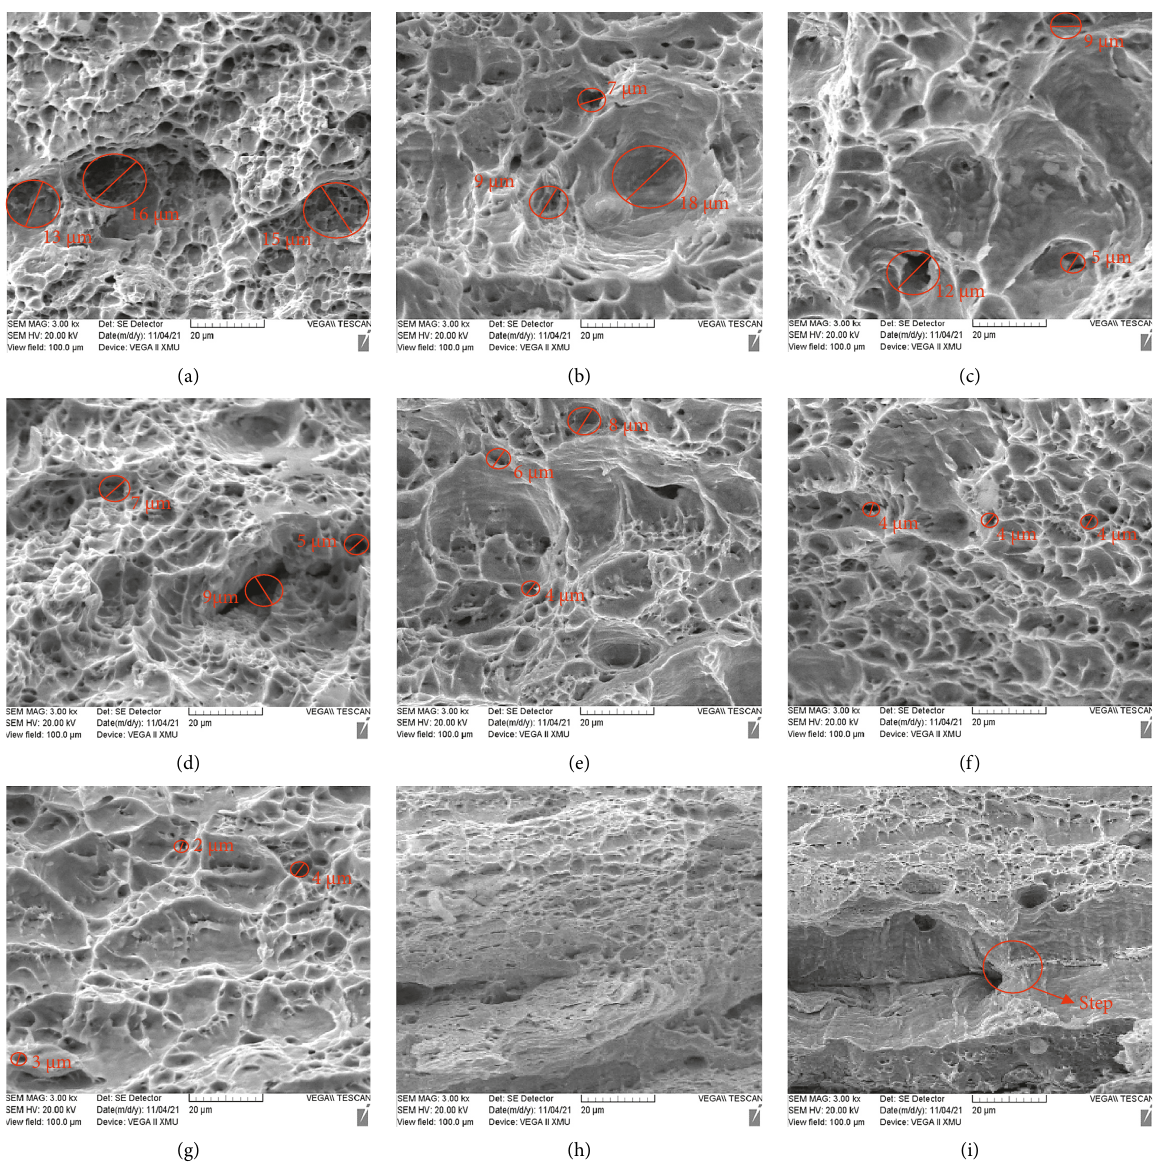
Figure 11: Fracture morphology. (a) 0 h. (b) 1 h. (c) 2h. (d) 4h. (e) 8h. (f) 12h. (g) 24h. (h) 48h. (i) 72h.